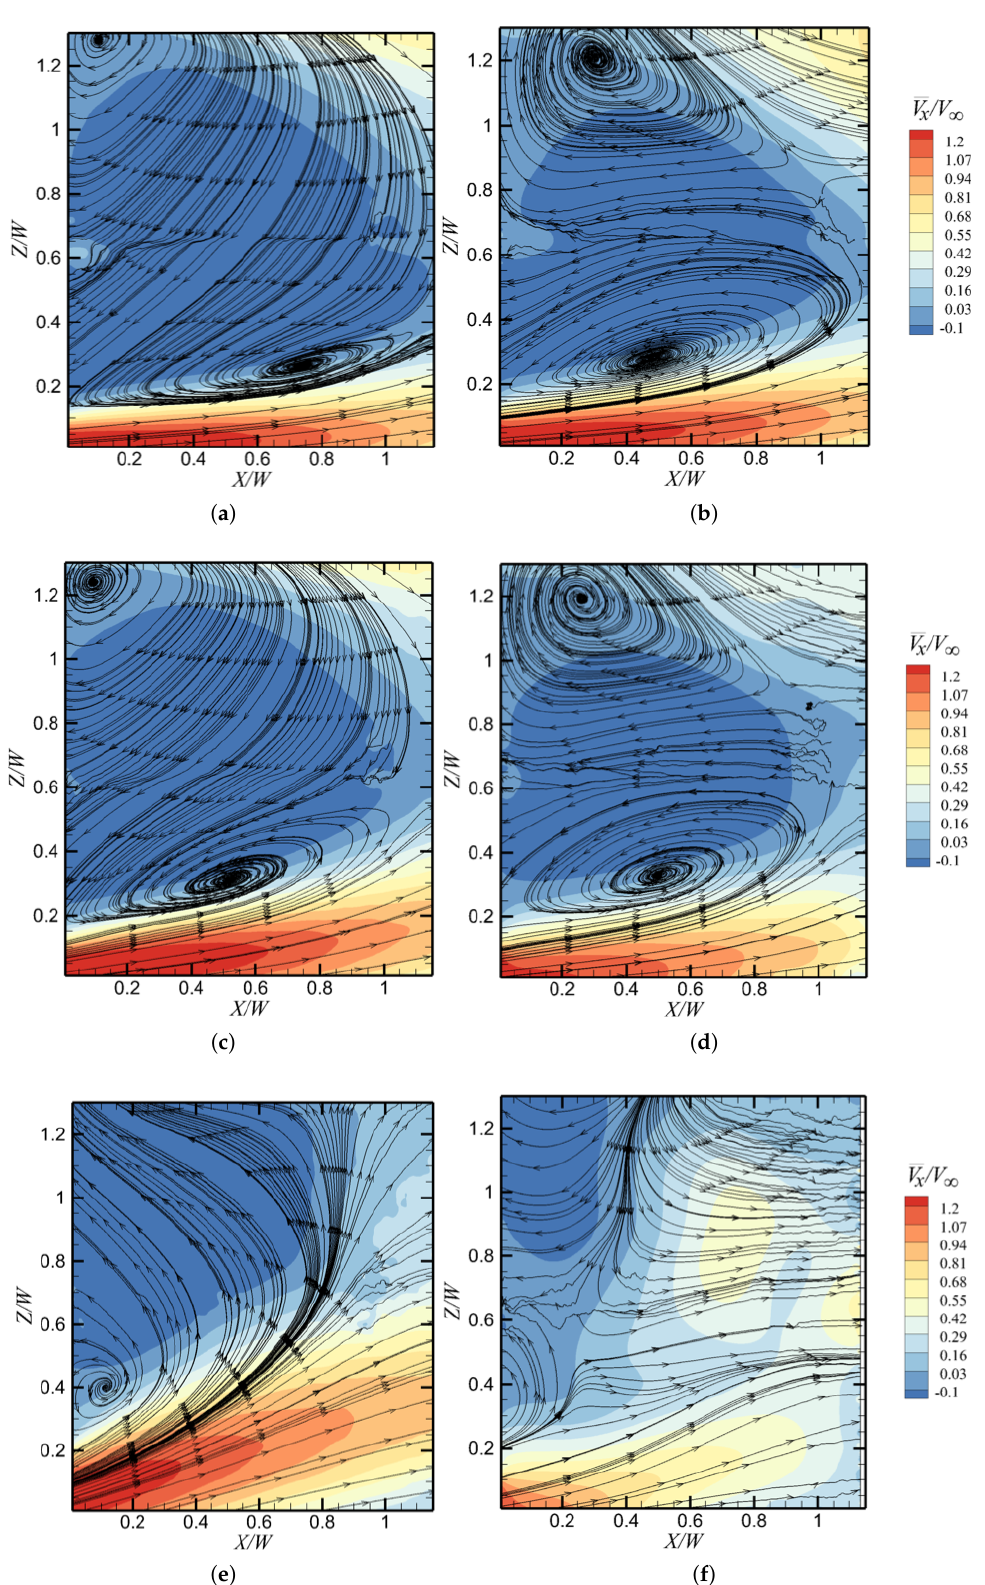
Figure 14. Contour representation of the mean streamwise velocity component V X / V ∞ in the following cases: ( a , b ) natural; ( c , d ) best compromise; and ( e , f ) maximum drag reduction ( Y / W = 0 , left column and Y / W = 0.2 right